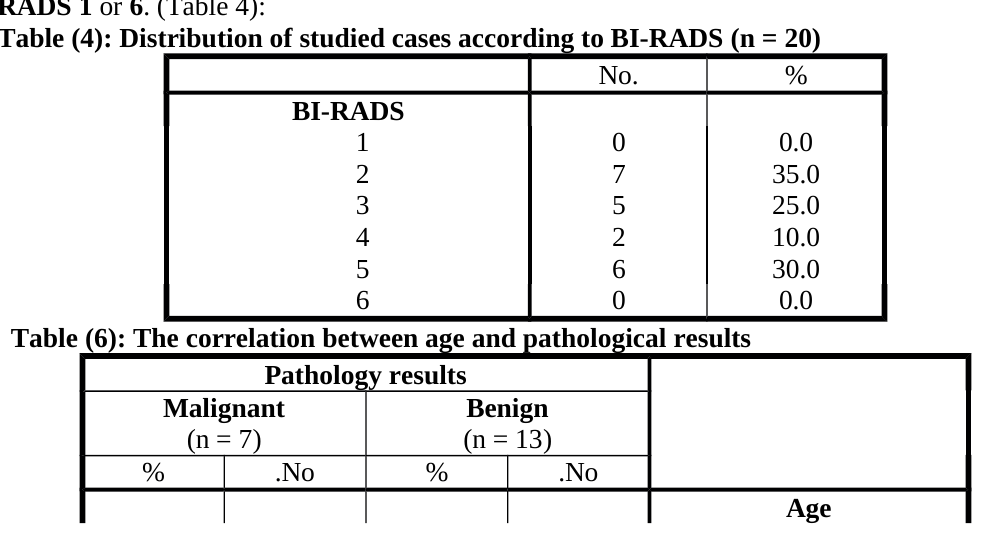
Table (4): Distribution of studied cases according to BI-RADS (n = 20)